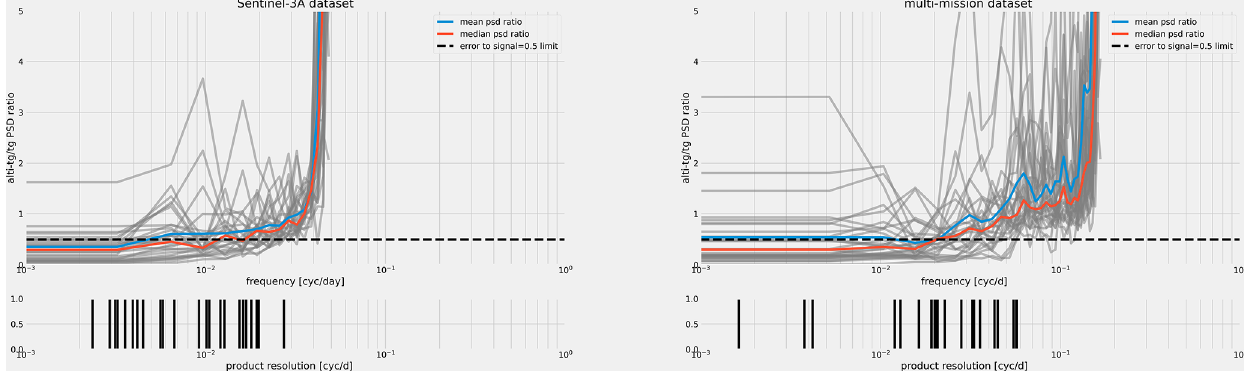
Figure 10. Ratio of the error power spectrum to the signal power spectrum at tide gauges (gray lines); the mean (blue) and median (red) ratios are shown. The resolution threshold is displayed as a dashed black line. Resolution values are displayed (in cycles per day) in the bottom panels. The left panel is for a single altimeter (S3A) product and the right panel for the combined product. In the legend, psd signifies power spectral